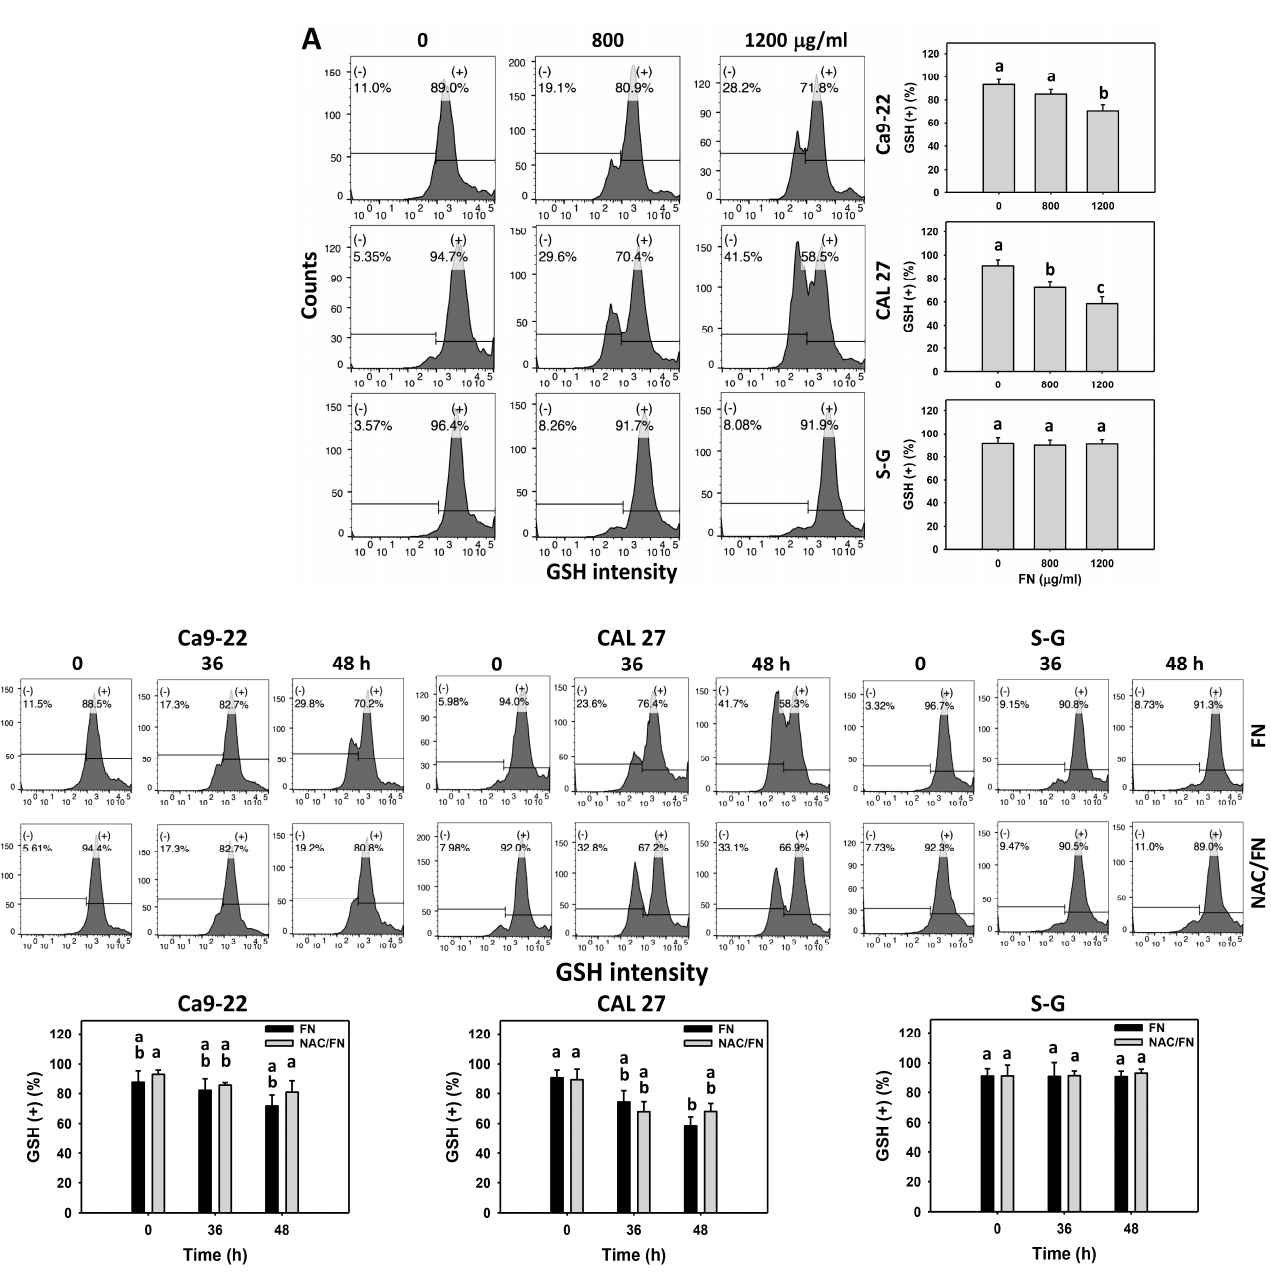
Figure 6. Fucoidan drives GSH depletion in oral cancer cells. ( A ) GSH flow cytometry density plots and summary histogram analyses. Oral cancer (Ca9-22 and CAL 27) and non-malignant cells (S–G) were treated with fucoidan (control, 800, and 1200 μg/mL) for 0 and 48 h. (+) indicates high levels of GSH. ( B ) The effect of oxidative stress on the GSH depletion of fucoidan-incubated oral cancer cells. After NAC preincubation or not, cells were treated with fucoidan (1200 μg/mL) with NAC co-treatment (10 mM) for 0, 36, and 48 h. In general, the actual setting for the windows is based on the same GSH intensity of the controls between different cell lines. NAC/fucoidan (NAC/FN) represents the pretreatment with NAC and post-treatment with FN. Data = mean ± SD ( n = 3 experiments). Data with non-overlapping letters reveal significant differences ( p < 0.05). In the example of Figure 6A (CAL 27 cells), FN at 0, 800, and 1200 μg/mL, labeled with the connecting letters “a, b, and c”, has significant results, because the letters do not overlap. In contrast, in the example of Figure 6A (S–G cells), FN at 0, 800, and 1200 µ g/mL labeled with “a” has nonsignificant results because they overlap with